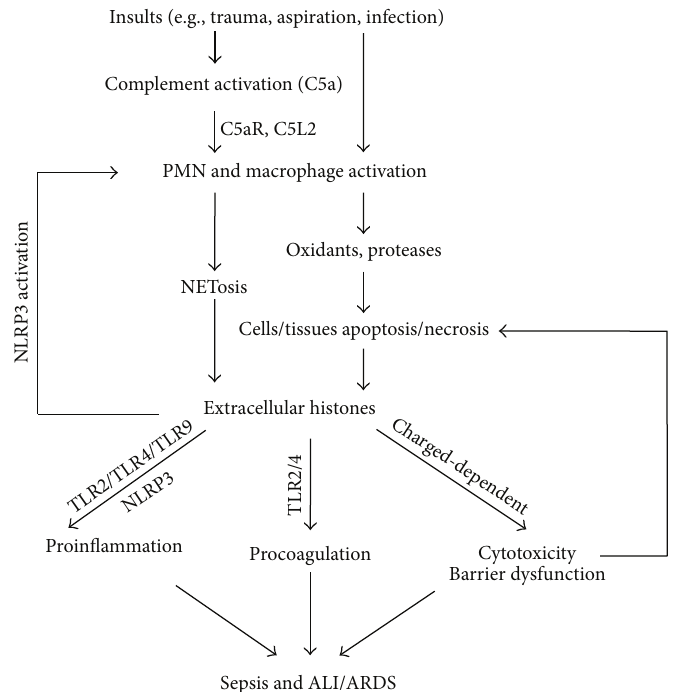
Figure 1: Proposed mechanisms of extracellular histones in the development of sepsis and ALI/ARDS. In response to various physical challenges (e.g., trauma, infection), polymorphonuclear neutrophils (PMN) and macrophages are recruited and activated through complement interaction (C5a and C5a receptors), which is often needed for extracellular histones presented in ALI/ARDS models. However, the accumulation of PMNs sometimes occurs with infection without complement activation. Under these conditions, histones derived from NETosis and dying nonleukocytic cells could be released. Once the histones are present in the extracellular space, they can directly bind to and damage phospholipids in cell membranes in a charged-dependent mechanism, leading to increased membrane permeability and death. They can also act on TLR2, TLR4, and TLR9 and activate the NLRP3 inflammasome to amplify inflammatory responses by the growing release of cytokines and other mediators. Moreover, circulating histones may also enhance coagulation disorders by acting on TLR2 and TLR4. On the other hand, extracellular histones perpetuate detrimental cell/tissue injury and could in turn induce the formation of NETs by activating the NLRP3 inflammasome, which together lead to more histones being released and greater severity of sepsis and ALI/ARDS.